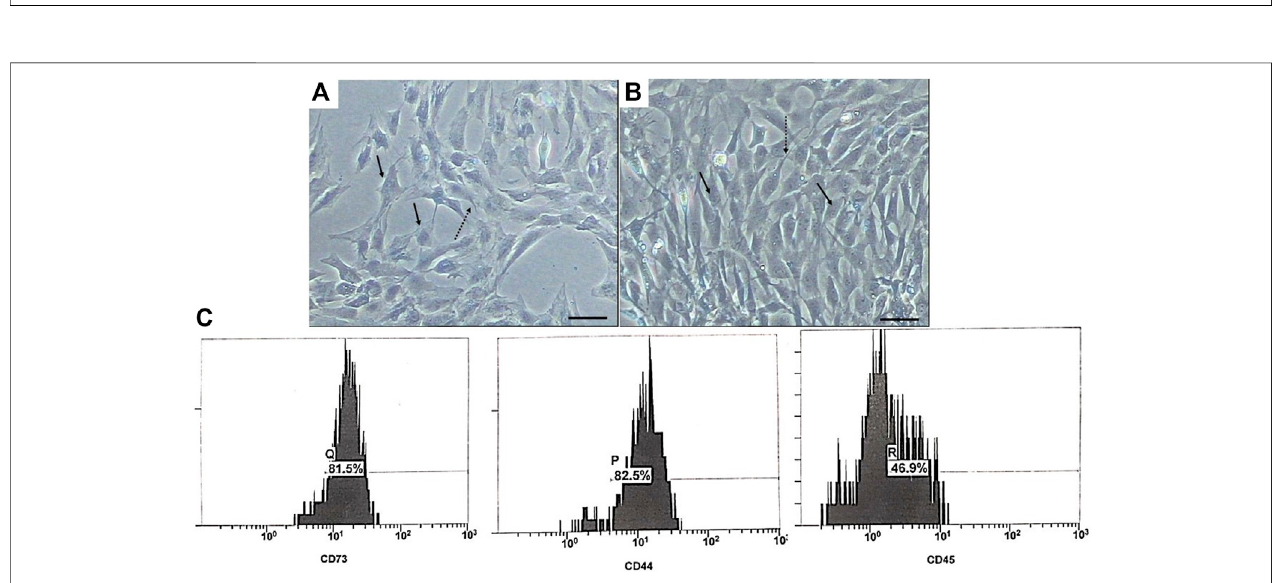
FIGURE 3 | Phase contrast photomicrographs of USCs during P1 (A) and P3 (B) . The cells exhibited fi broblast-like appearance with short cytoplasmic processes (dashed arrow), and their nuclei were vesicular with multi nucleoli (arrow). Scale bar: 100 μ m. (C) Flow cytometry phenotypic analysis of USCs.